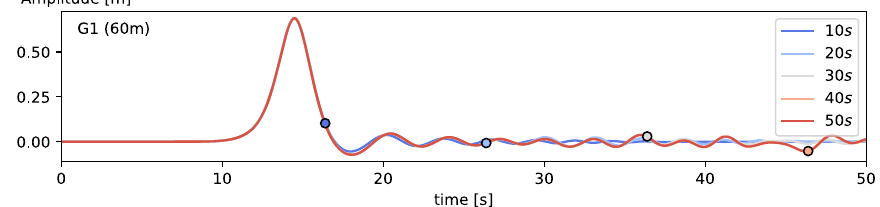
Fig. 7 Solitary wave example. Set of analysis where the interface is active only in a part of the time domain. The marker shows when the solution tends to the resting condition